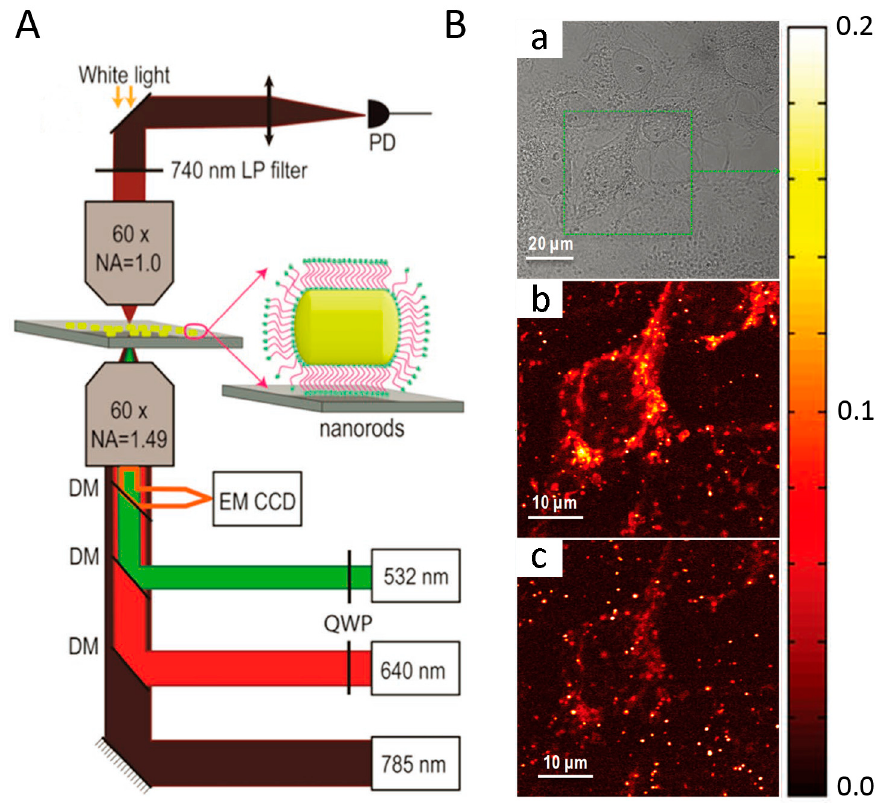
Figure 6. ( A ) Schematics of the two-color photothermal imaging microscopy with a near infrared probe beam at 785 nm and excitations beam at 532 or 640 nm; ( B ) White light ( a ) and PhI images of COS 7 cells incubated with nanorods under ( b ) 532 and ( c ) 640 nm excitation. Photothermal imaging microscopy recorded under red excitation shows very weak mitochondrial background signals compared to those acquired under green excitation [78].